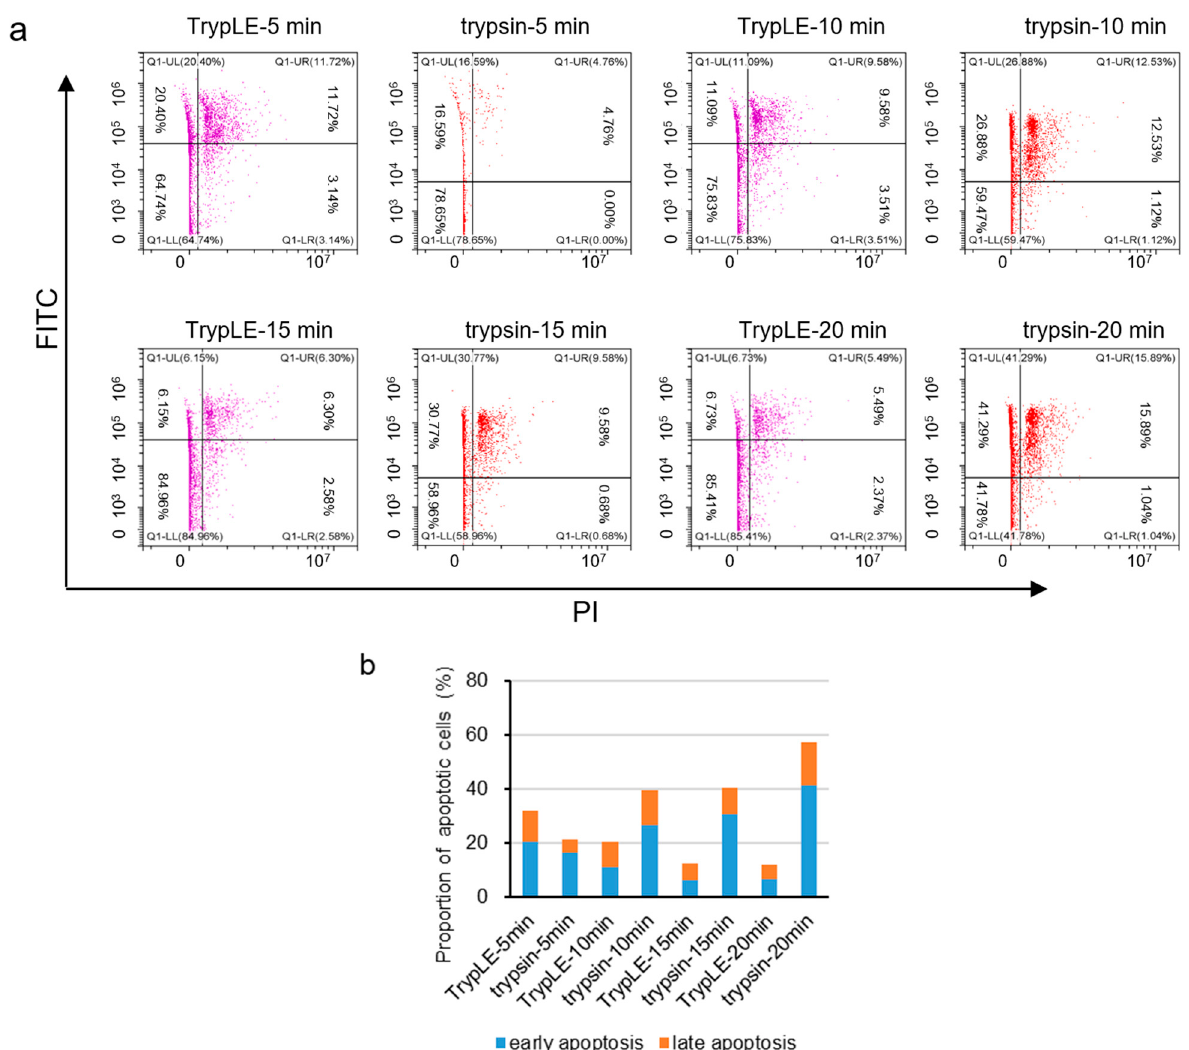
Figure 2. Animal-based enzymes promote cell apoptosis compared with animal-origin-free enzymes. ( a ) Animal-based enzymes and animal-origin-free enzymes at 37 ◦ C resulted in apoptosis. A total of 5 × 10 5 cells were plated in each well of a six-well plate, and, after culturing for 12–24 h, the cells were detached with animal-based enzymes (trypsin) or animal-origin-free enzymes (TrypLE) at 37 ◦ C for 5 min, 10 min, 15 min, or 20 min, and FITC (5-Fluoresceinisothiocyanate)/PI (Propidium Iodide) dual-color labeling flow cytometry was performed. Cells stained only with FITC represent early apoptotic cells, and cells stained only with PI represent cells with late apoptosis. ( b ) Quantification column chart of Figure 2a.